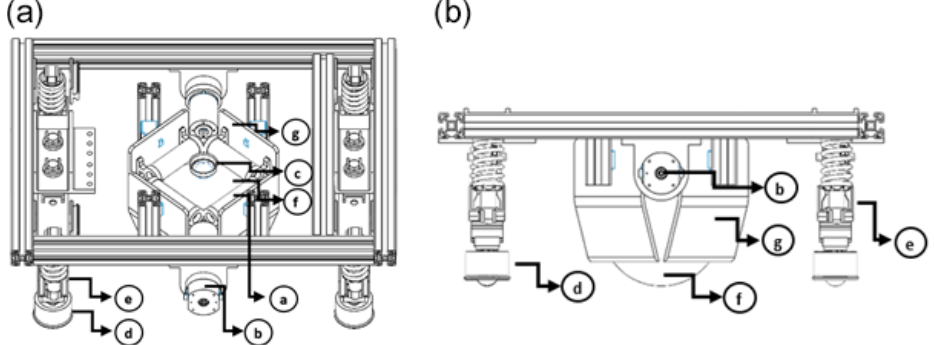
Figure 3. The platform elements, with (a) platform top view and (b) platform side view. Labels: (a) roller, (b) motor, (c) roller ball (transfer), (d) roller ball (support), (e) support base, (f) active spherical wheel, and (g) active spherical wheel support.